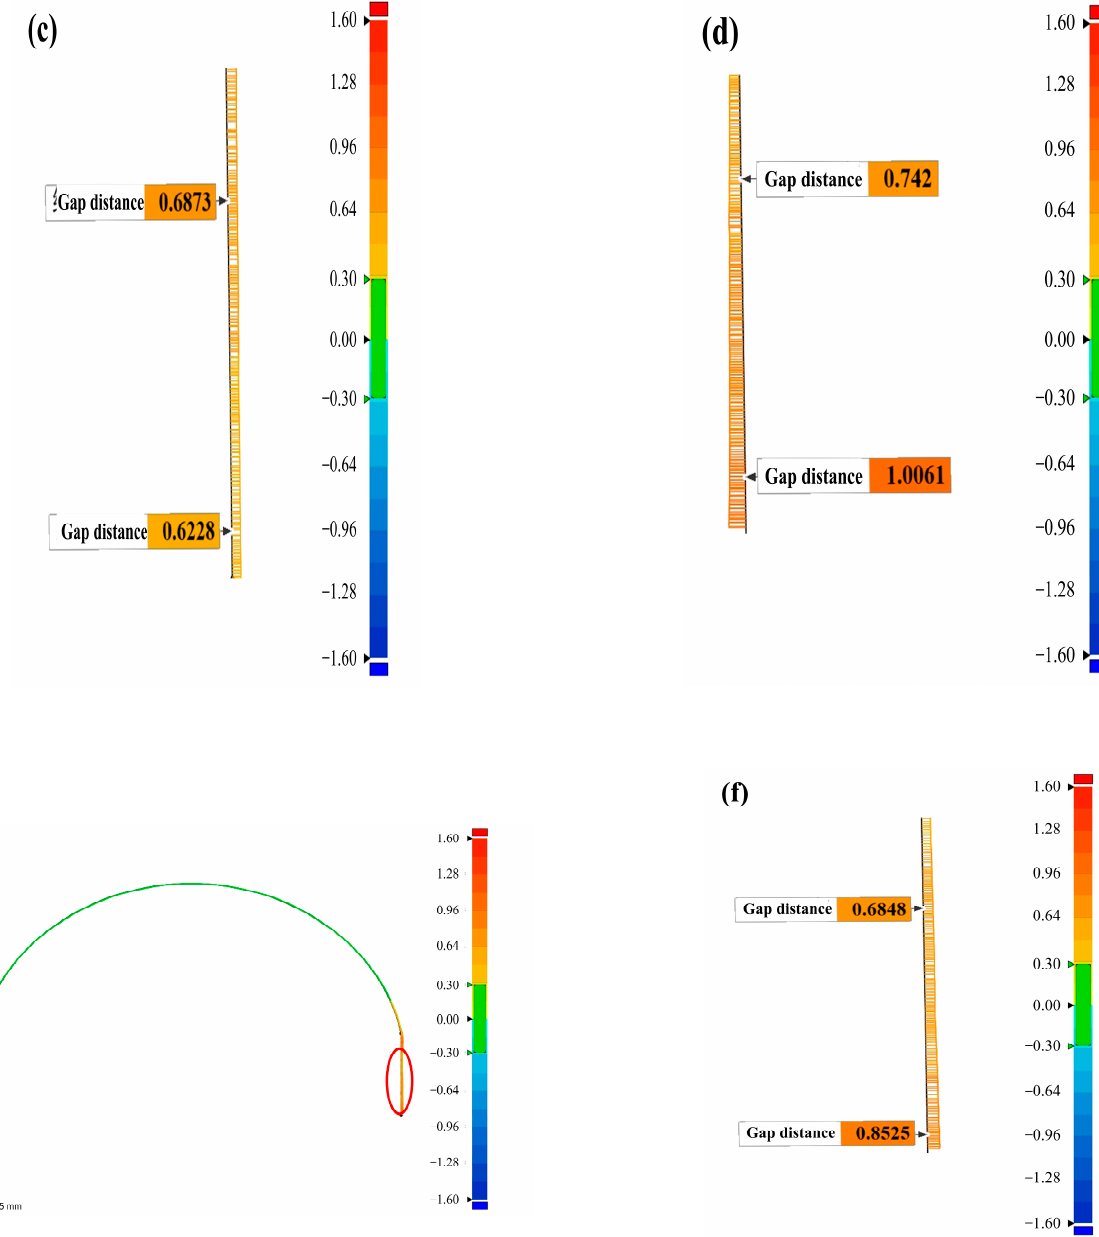
Figure 9. Deformation analysis of the installation platform section. ( a ) Deformation of the left side of the RTM helmet platform; ( b ) overall deformation of the RTM helmet installation platform; ( c ) deformation of the right side of the RTM helmet platform; ( d ) left side of the M-CRTM helmet platform deformation; ( e ) the overall deformation of the M-CRTM helmet mounting platform; ( f ) the deformation of the right side of the M-CRTM helmet platform.